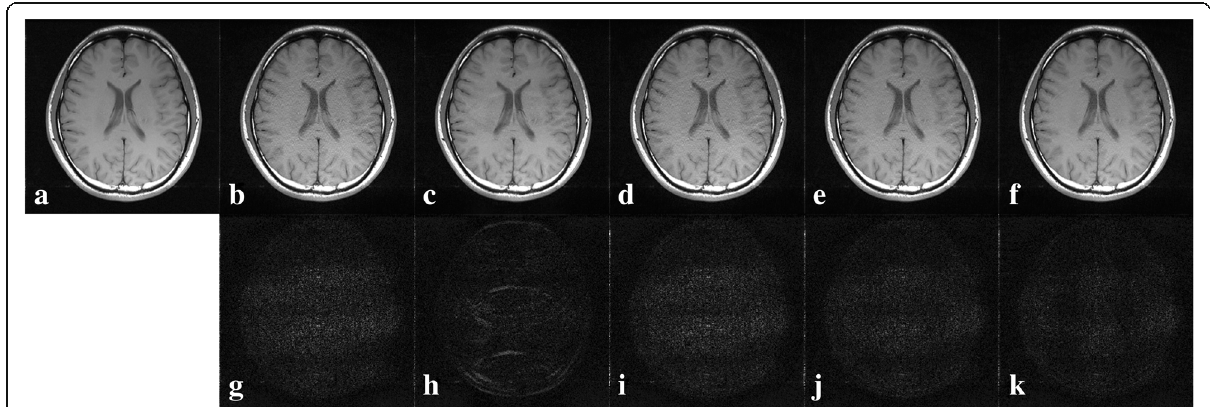
Fig. 4 Reconstructed images of a set of real eight-channel axial brain data. The acquisition is accelerated with a net reduction factor of 2.77. a Reference image with SoS reconstruction. b GRAPPA reconstruction with 38 ACS lines and 4 outer reduction factor. c GRAPPA reconstruction with 12 ACS lines and 3 outer reduction factor. d Reconstruction using Tikhonov regularization. e Reconstruction using IRLS method. f Reconstruction using AV-GRAPPA. g – k Difference maps of b – f , respectively. Similar to the results in Fig. 3, AV-GRAPPA reduces more noise than GRAPPA, Tikhonov regularization and IRLS method. In addition, since AV-GRAPPA has little ability to reduce aliasing artifacts, a few aliasing artifacts exist in the reconstructed image. But, aliasing artifacts also exist in other reconstructed images, compared to which, AV-GRAPPA keeps the aliasing artifacts at a